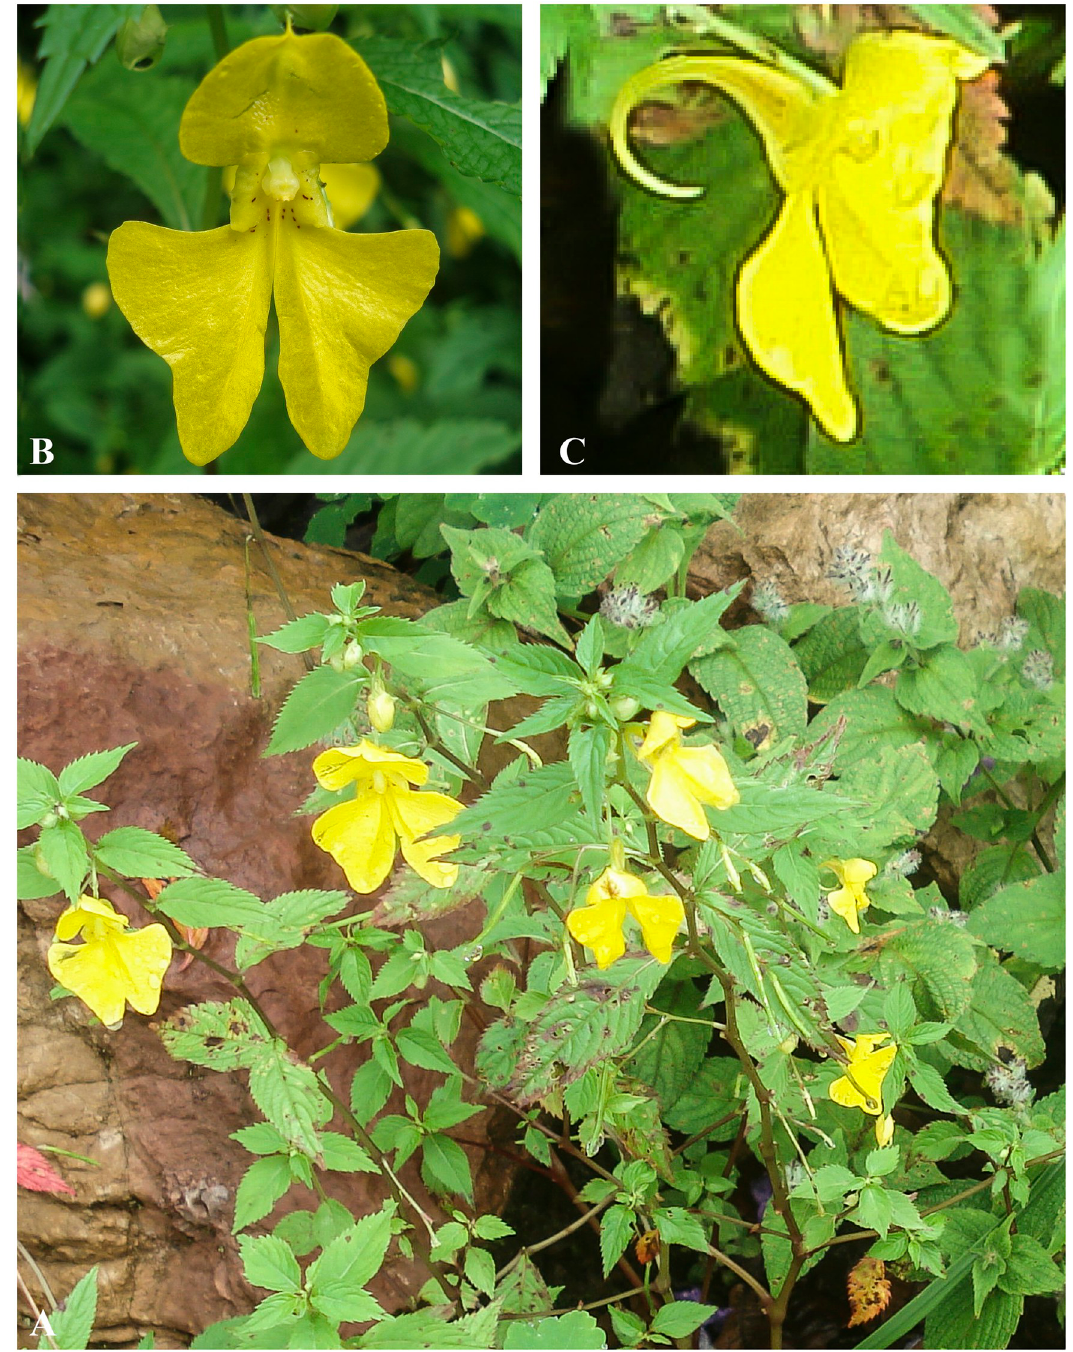
Fig 12. Impatiens falcifera A. Flowering plant; B. Flower (front view); C. Flower (side view). Photographs by Bhakta Bahadur Raskoti.